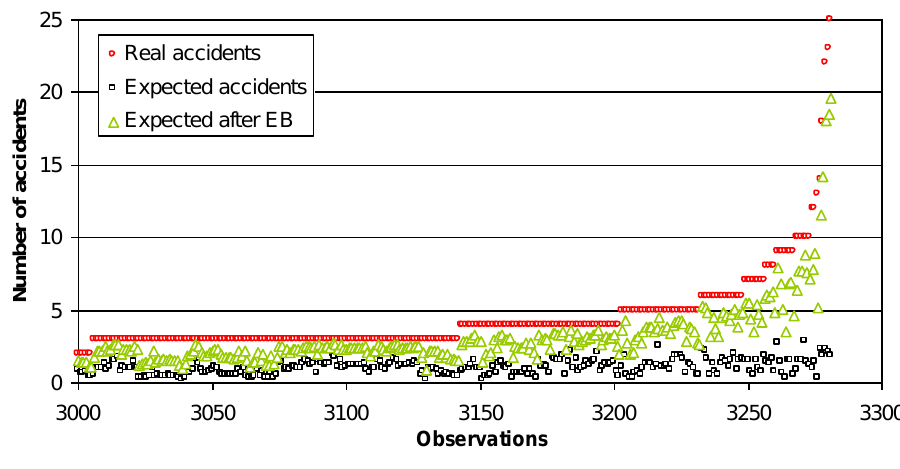
Figure 3. Expected number of accidents comparing real number of accidents and predicted number after applying EB method (road section of 500 m)—observation 3000 until 3300.